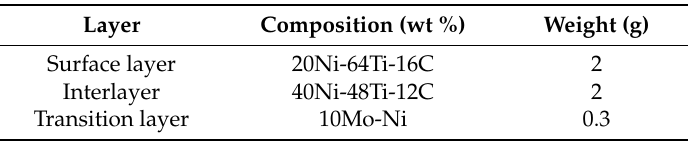
Table 2. Material design of TiC/Ni composite coating.